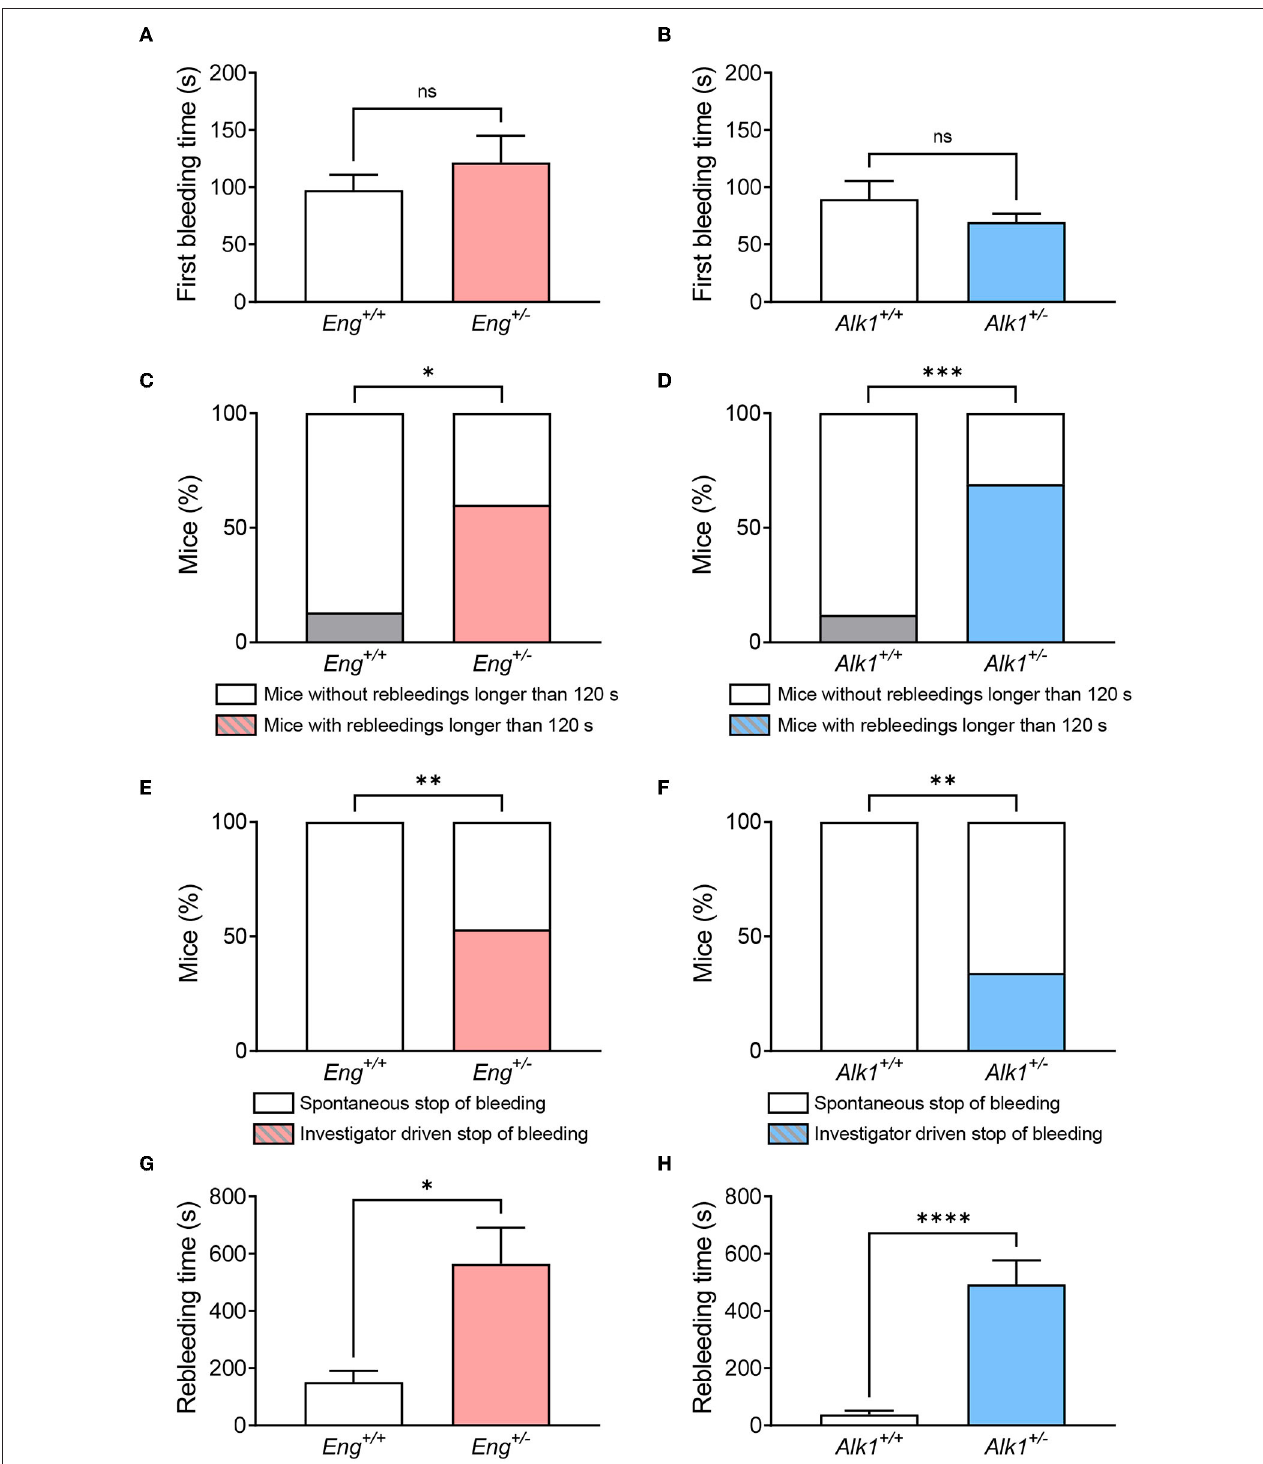
FIGURE 2 | (A,B) Time of first bleeding after cutting the tail tip in the HHT-1 murine model (A), Eng + / − mice ( n = 15) and its respective controls Eng + / + ( n = 15); and in the HHT-2 murine model (B) , Alk1 + / − mice ( n = 16) and its respective controls Alk1 + / + ( n = 29). (C,D) Percentage of mice showing rebleeds longer than 2min in the mouse model of HHT-1 (C) and HHT-2 (D) . (E,F) Proportion of mice that are able to stop rebleeding on their own compared to those that need investigator intervention to stop rebleeding in the animal model of HHT-1 (E) or HHT-2 (F) . (G,H) Rebleeding time, calculated as the sum of the time taken for the different spontaneous rebleeding times that a mouse may have during the experiment, for Eng-deficient mice and their controls (G) , as well as for Alk1-deficient mice and their controls (H) . Results were considered statistically significant if p < 0.05 (ns: non-significant; *: p < 0.05; **: p < 0.01; ***: p < 0.001; ****: p < 0.0001).